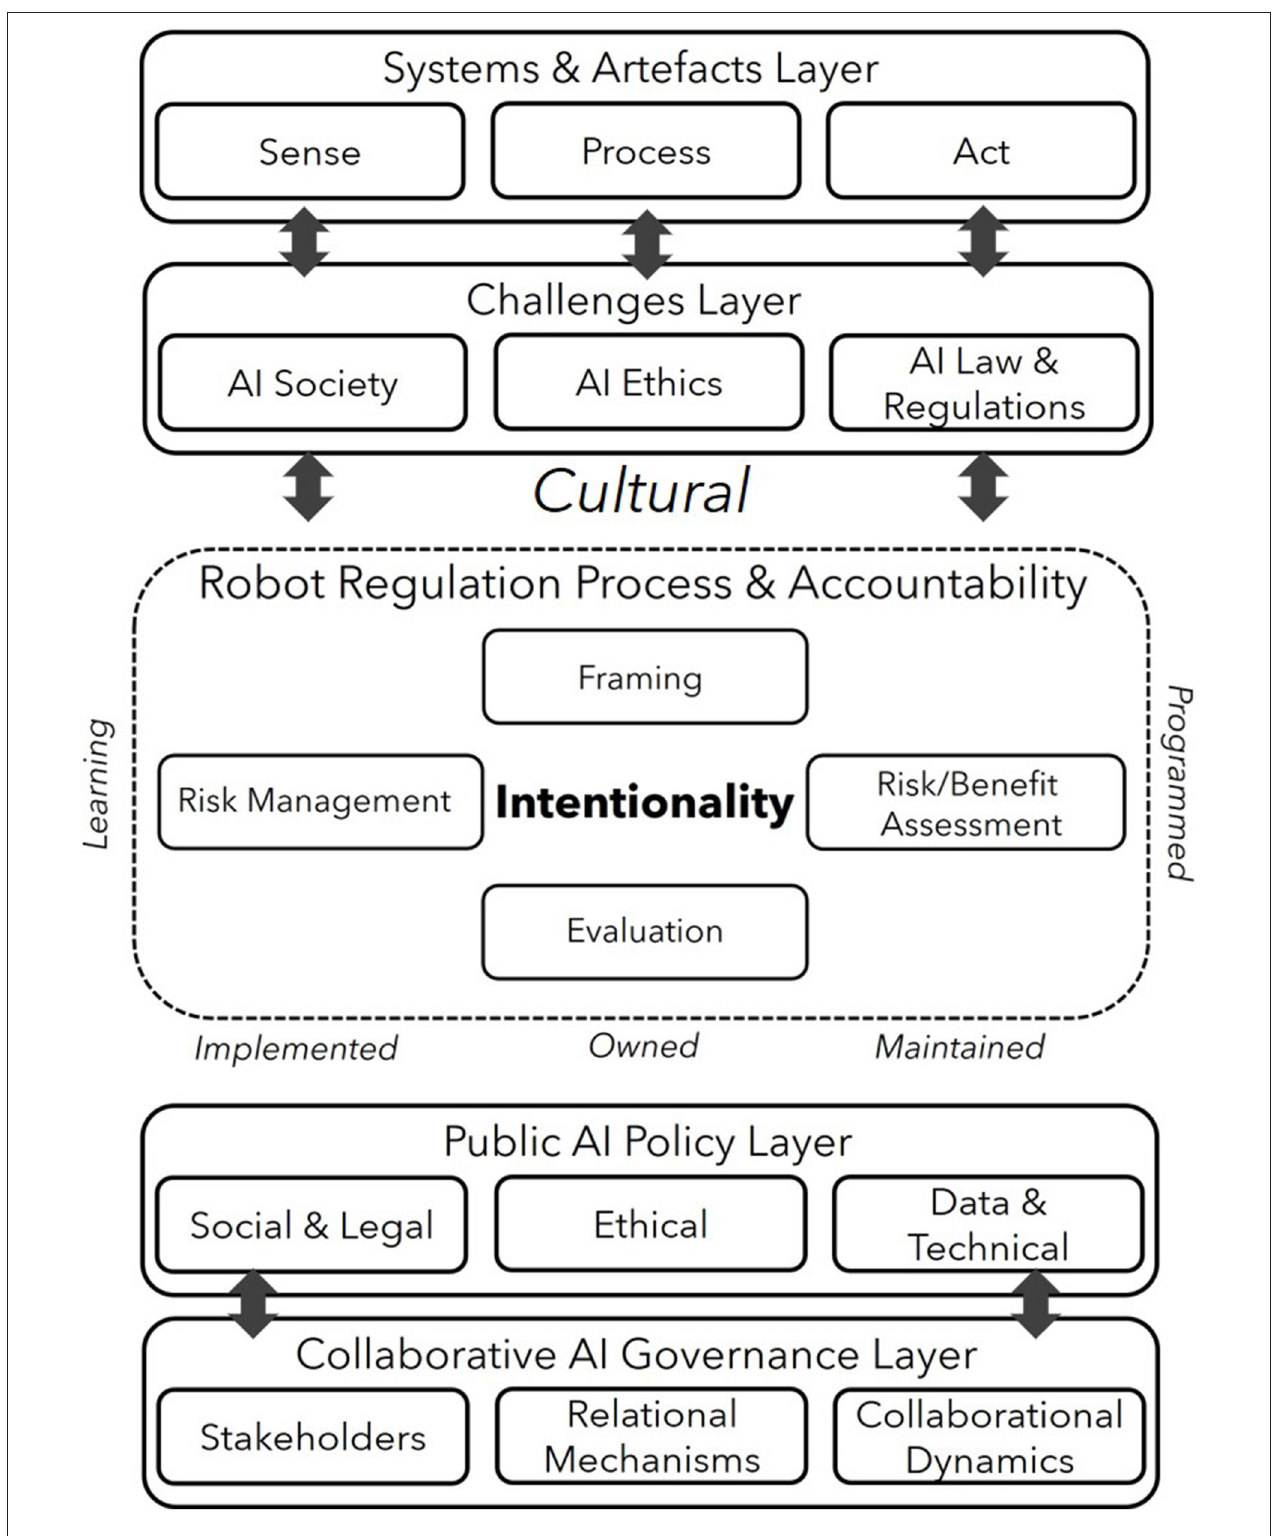
FIGURE 1 | Ethical responsibility model for robot governance [ER-RoboGov; adapted from Wirtz et al. (2020), p. 818–829].